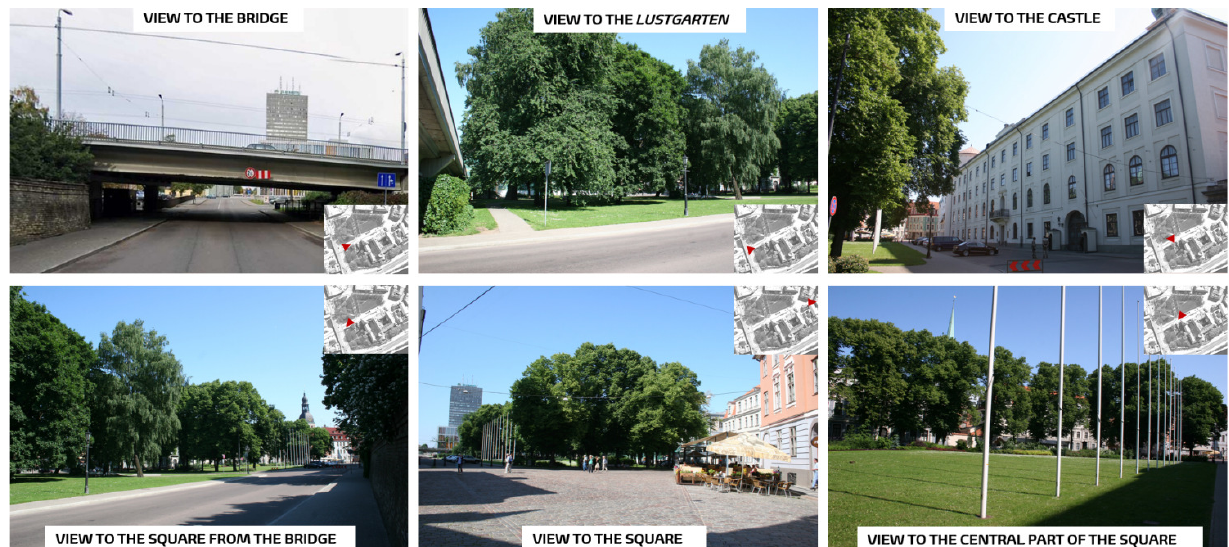
Figure 2. Main viewpoints to the Castle